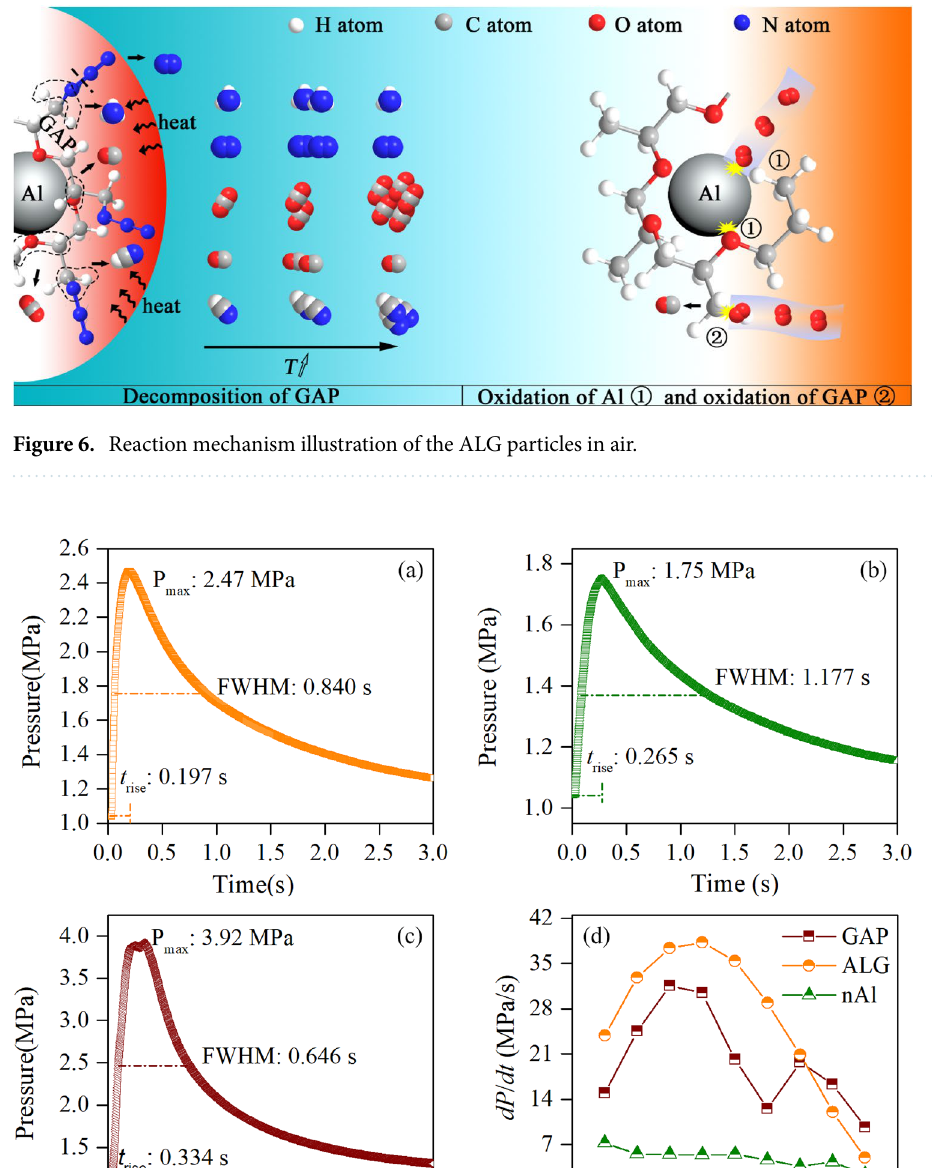
Figure 7a–c displayed the P – t curves of the ALG particles, the nAl particles and the GAP, respectively. The P max of the ALG particles, the nAl particles and the GAP were separately 2.47 MPa, 1.75 MPa, and 3.92 MPa. The P max of the ALG particles was 36% smaller than that of the GAP because the amount of the gas products of the former was much less than that of the latter. The P max of the ALG was 41% larger than that of the nAl, due to the additional heat release and gas products generated by the decomposition of the GAP coating layer. Besides, the t rise and the FWHM of the ALG were separately 0.197 s and 0.840 s, which were separately decreased by 26% and 29% compared to those of the nAl particles. It indicated the reaction rate of the former was faster than that of the latter, which was consistent with the DSC results. To further understand the evolvements of the pressures before reaching to the P max , the d P /d t histories over P / P max of the three samples were analyzed, as shown in Fig. 7d. For the case of the ALG particles, the d P /d t kept increasing with the increase of P / P max before P / P max = 0.4. However, for the case of the nAl particles, the d P /d t simply decreased with the increase of the P / P max . Furthermore, the d P /d t of the ALG particles was larger than that of the nAl particles from P / P max = 0.1 to P / P max = 0.9; In addition,